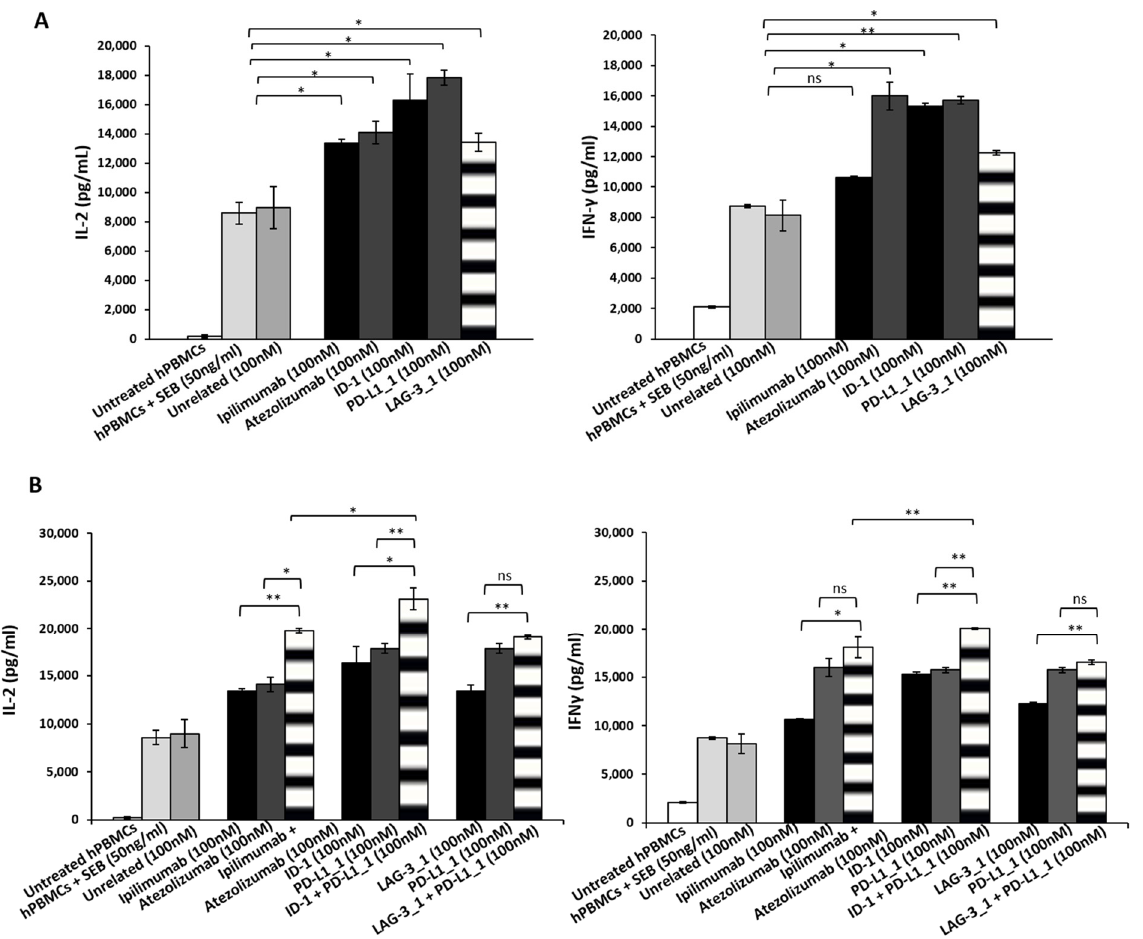
Figure 1. Effects of novel mAbs on the activation of stimulated lymphocytes. hPBMCs were stimulated for 66 h with SEB in the absence or in the presence of anti-CTLA-4 (black bars), anti-PD-L1 (dark grey bars) or anti-LAG-3 (striped bars) mAbs used alone ( A ) or in combination ( B ). In the panel B the levels of IL-2 and IFN- γ secreted were measured by ELISA (black bars for anti-CTLA-4 and anti-LAG-3 mAbs, dark grey bars for anti-PD-L1 and striped bars for combinations). Untreated hPBMCs or treated with an unrelated IgG were used as negative controls (white and grey bars, respectively). Error bars depict means ± SD. p -values for the indicated compounds are: ** p < 0.01; * p < 0.05.